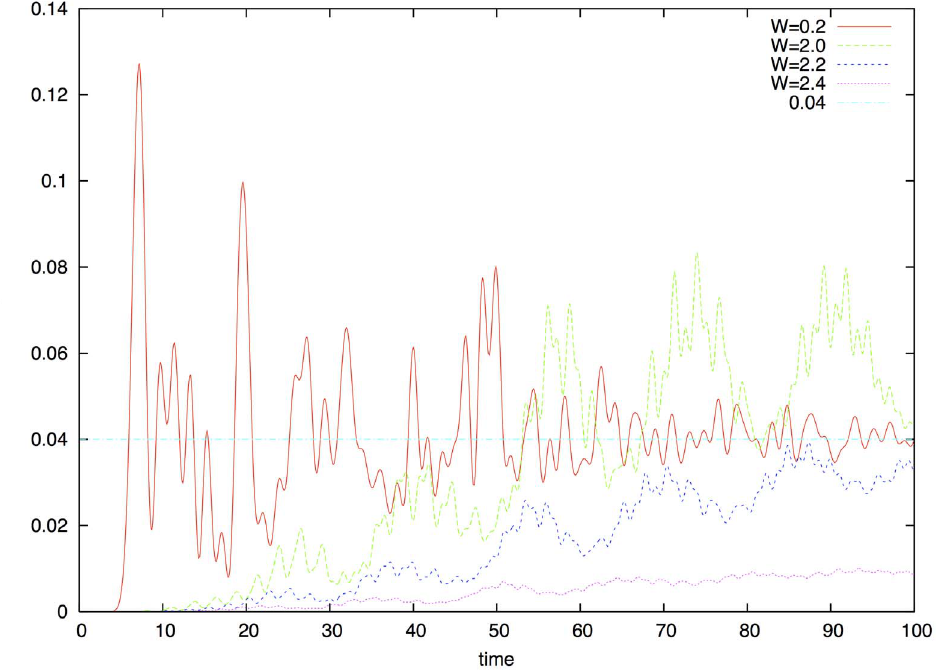
Figure 3. Probability that the exciton started on chromophore 1 is on chromophore 13 % 1,13 . Below the transition ( W ~ 0 : 1 ) coherence dies out quickly and the probability reaches its asymptotic value 1 = 25 . The beats at times 6 : 5 and at 19 : 5 reflect interference from clock and anti- clockwise traveling waves interfering after taking half and 1.5 rounds. In the transition point and above we can see that due to the localization it takes much longer time for the excitation to arrive at the opposite end. If we are just slightly above the transition coherent beats smear out by the time they arrive. The reason is that propagation becomes mostly classical as localization stops quantum diffusion. In the critical point however quantum propagation and coherence is possible at the same